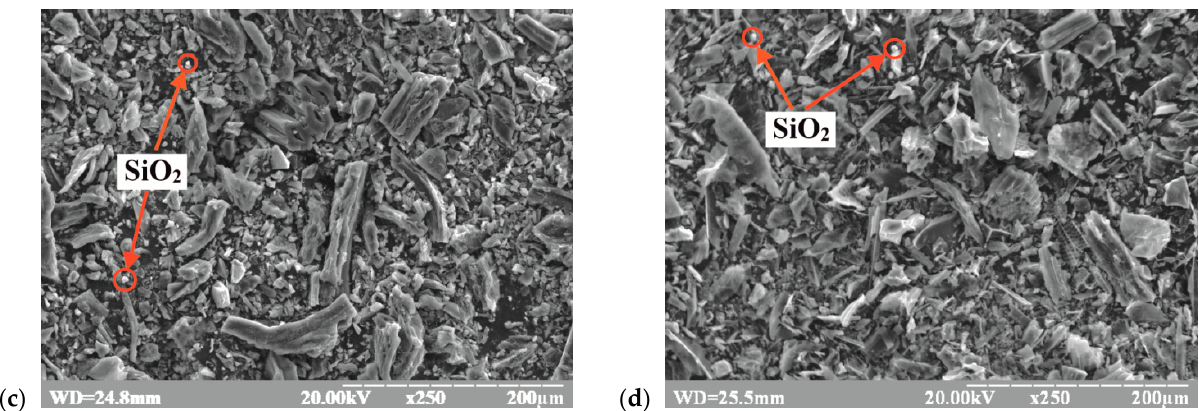
Figure 1. SEM images of ACB0 ( a ), ACC0 ( c ) carbons, ACB-Ni ( b ), and ACC-Ni ( d ) Ni/C composites.